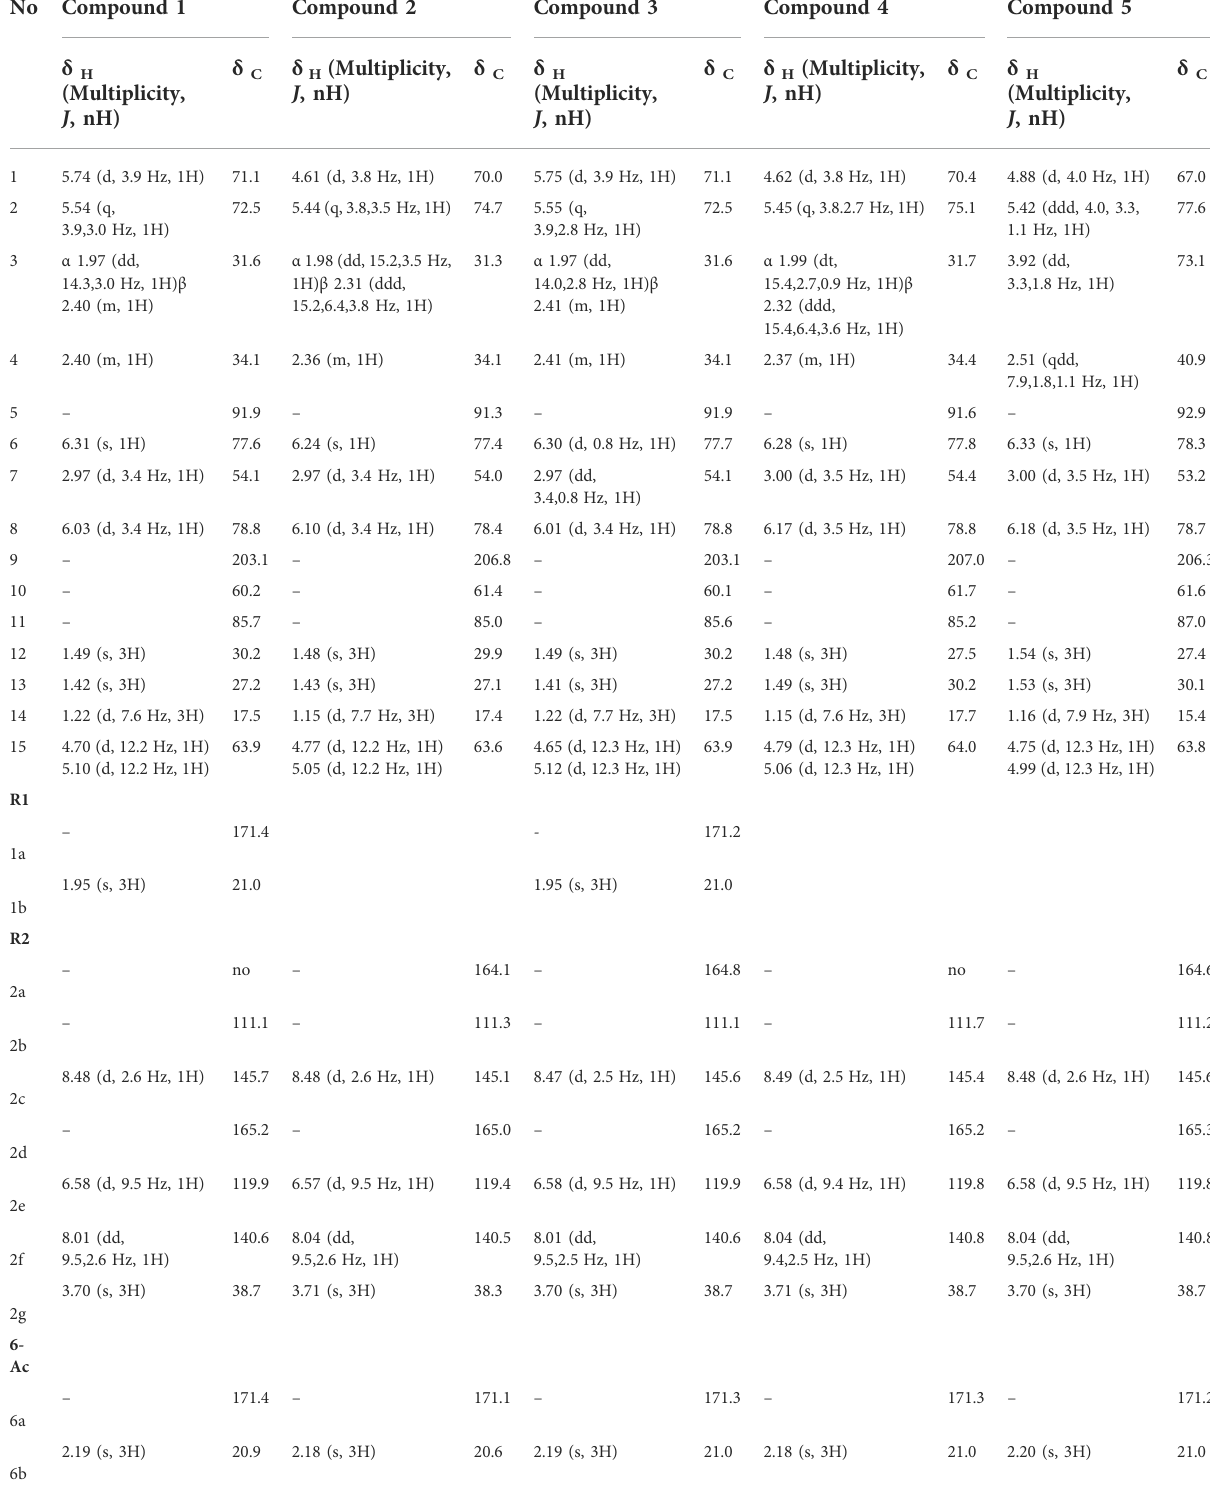
TABLE 3 1 H and 13 C NMR spectroscopic data for compounds 1 – 5 ( δ in ppm, J in